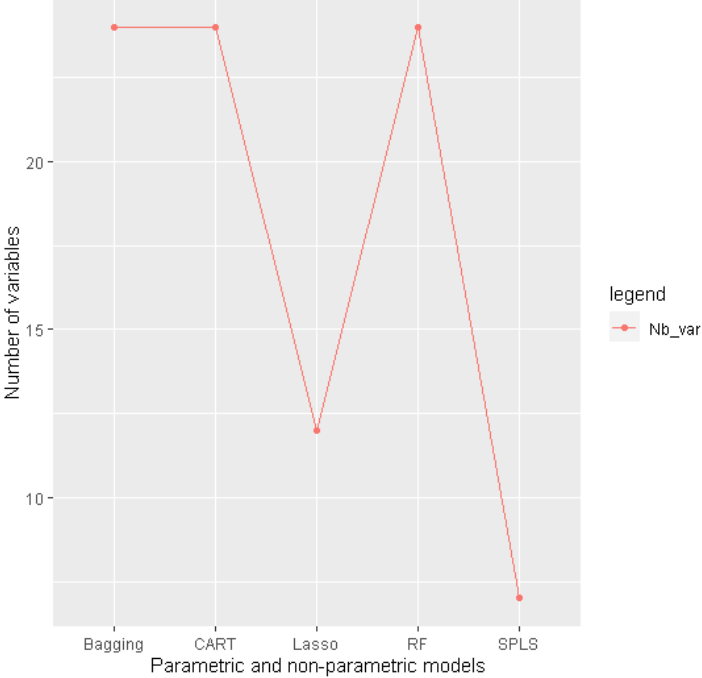
Figure 5. Comparison of model performance according to number of